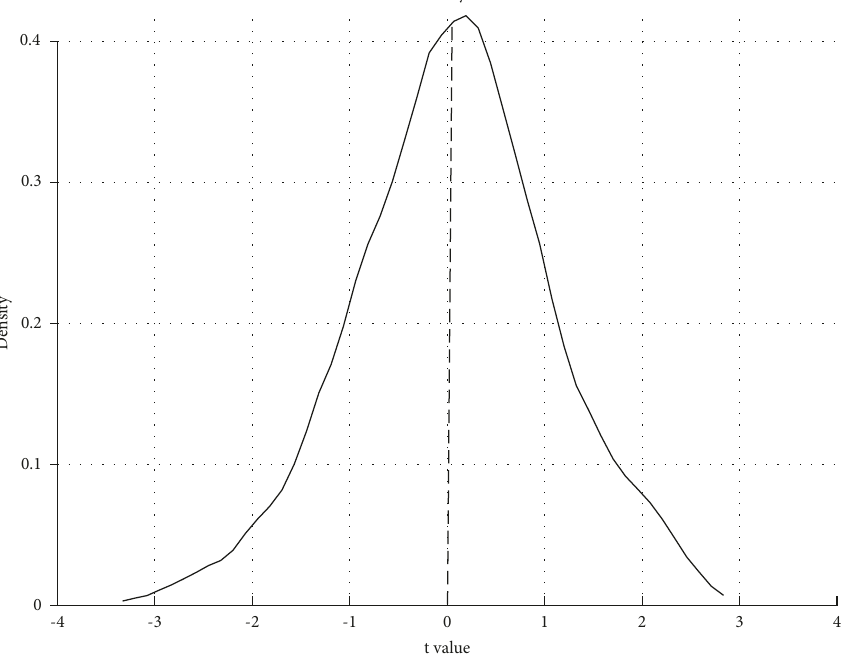
Figure 1: Distribution of the stochastically processed β